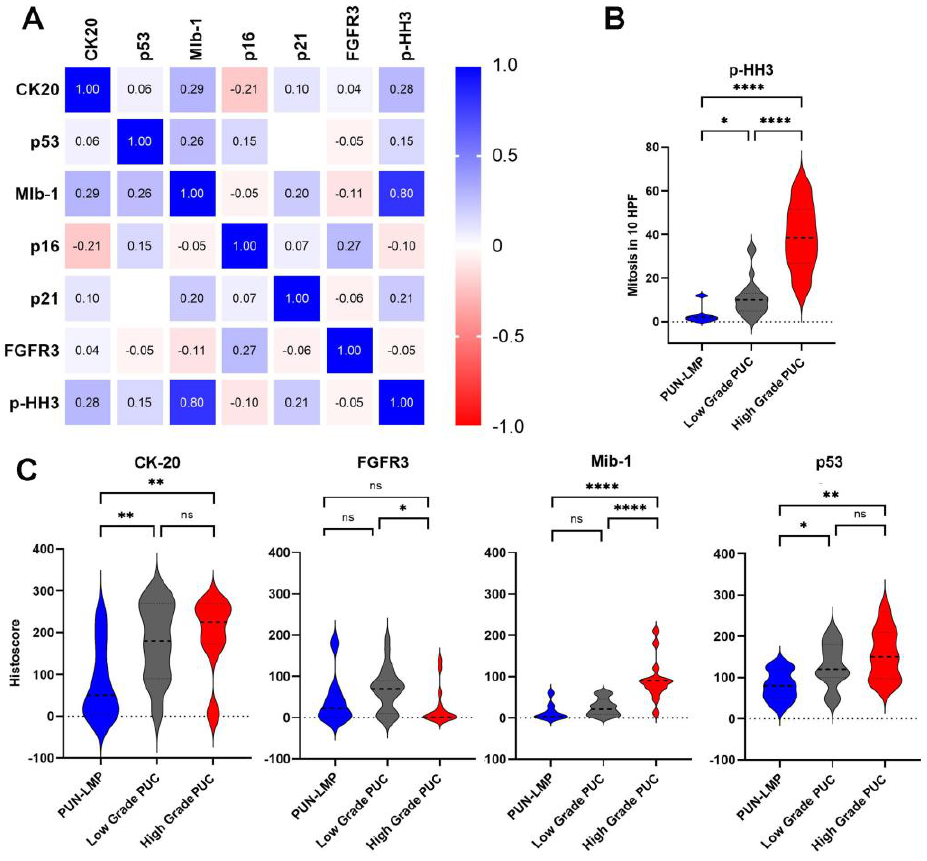
Figure 2. Immunohistochemical features. ( A ). Spearman’s rank correlation matrix and correlation significances of immunohistochemical variables. Values show the Spearman rank results; blue colors show positive correlations and red colors negative correlations. ( B ). Violin plots comparing the number of mitotic counts in 10 high power fields (HPF) stained with p-HH3 among non-invasive PUC categories. ( C ). Violin plots of the different histoscores of the immunohistochemistry markers, denoting the non-invasive PUC entities. For statistical analysis unpaired t -test was used, ns= not Table 3. Histoscores of cases according to the histological